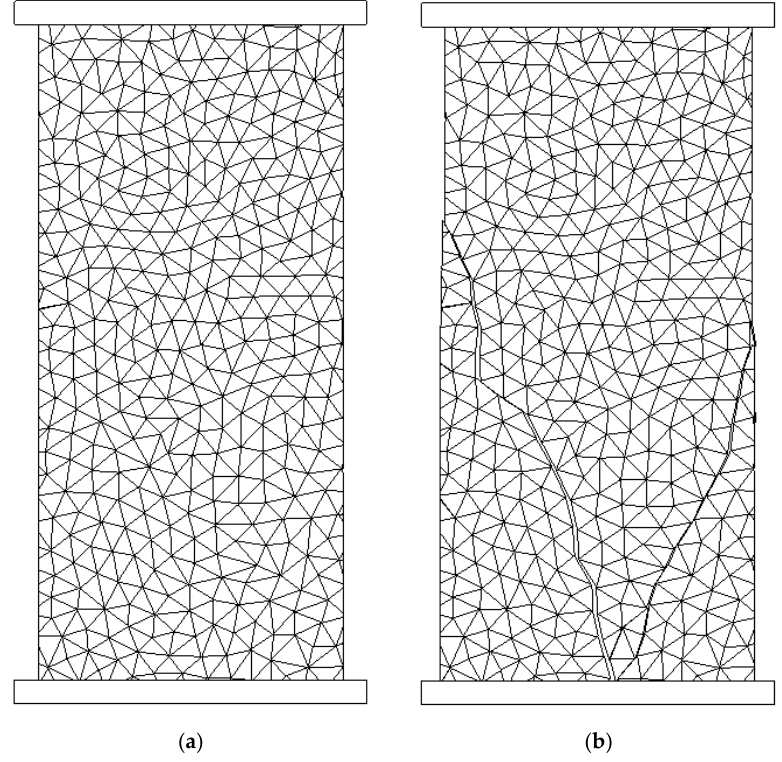
Figure 13. ( a ) Model with triangular inner-blocks; ( b ) Failure mode. Table 5. Comparison of compressive strength (MPa) for Voronoi and triangular block models. Block Shape